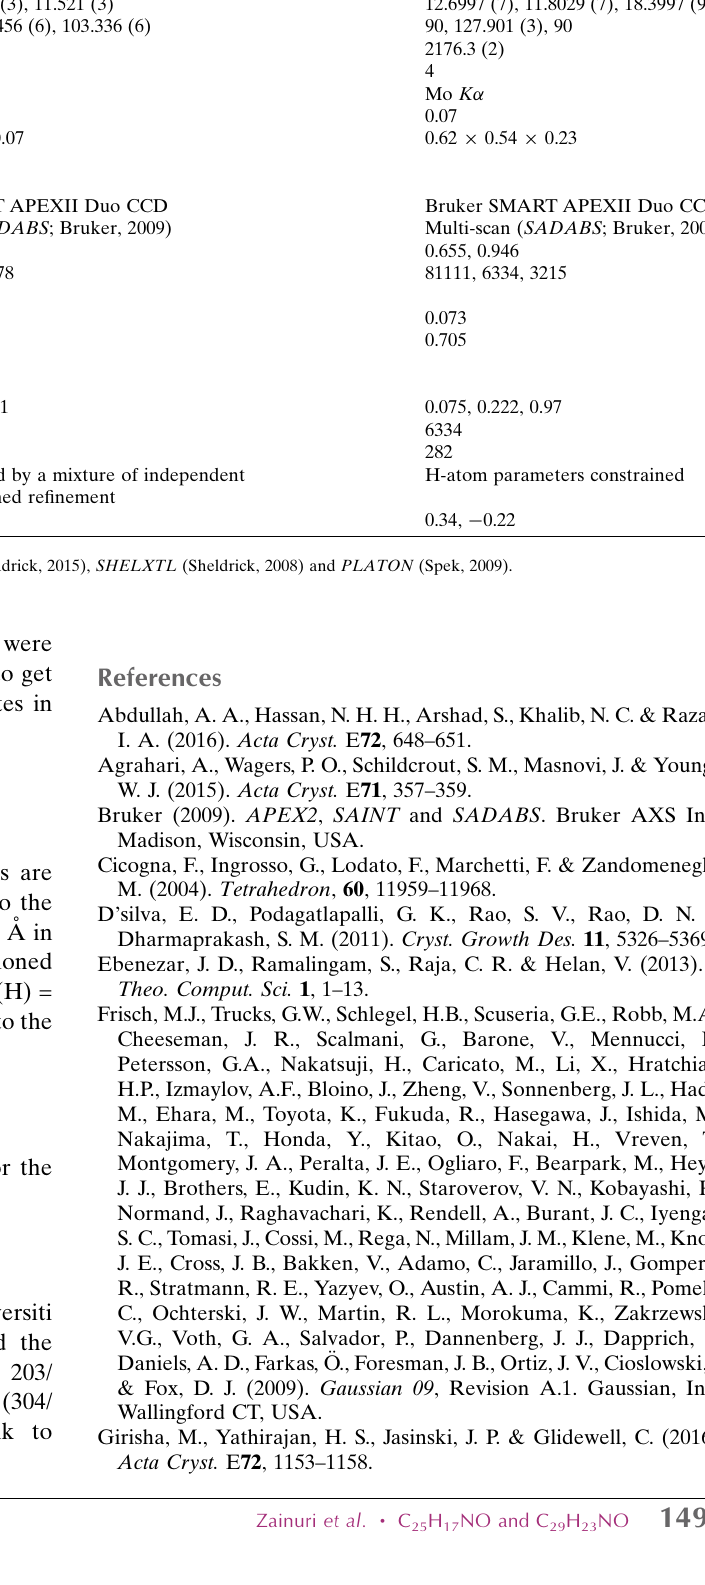
Crystal data Chemical